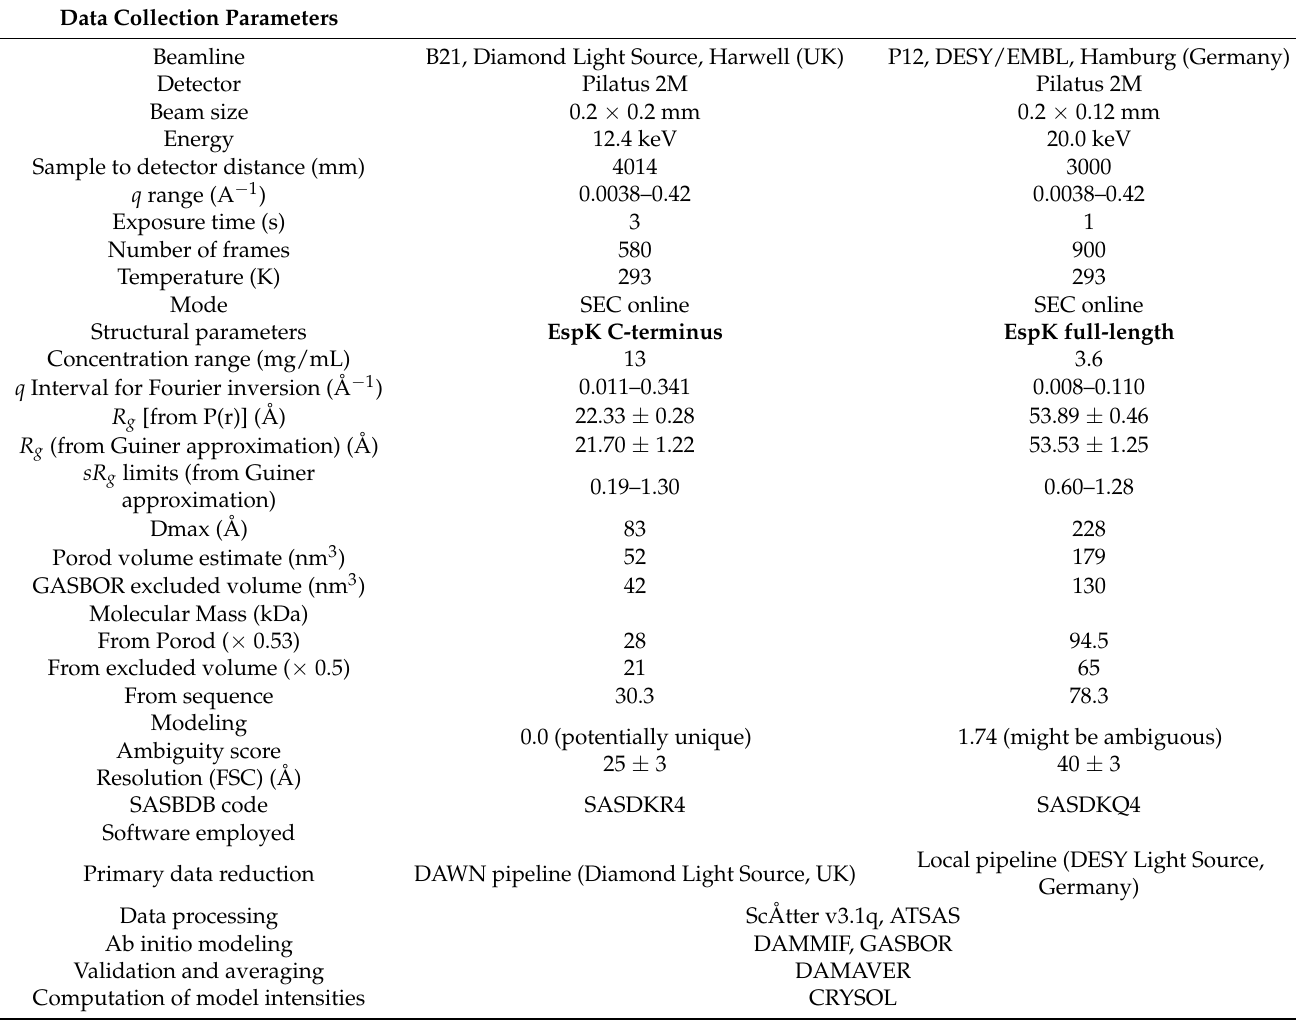
Table 1. SAXS data collection and scattering-derived parameters for the M. tuberculosis EspK